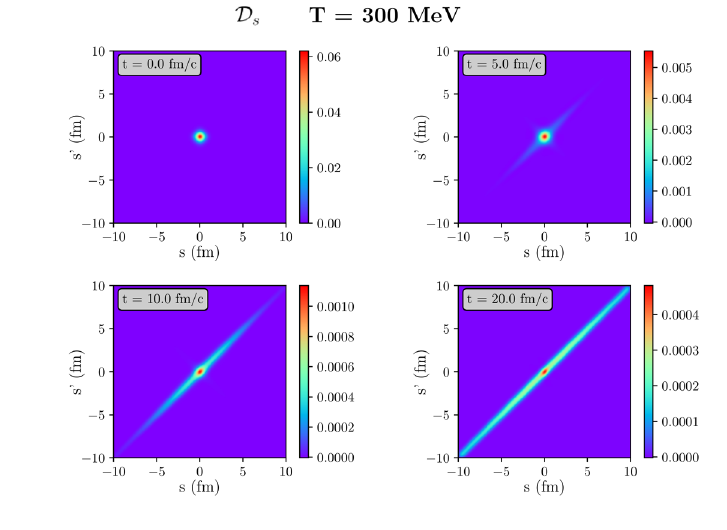
over time for a temperature T = 300 D s